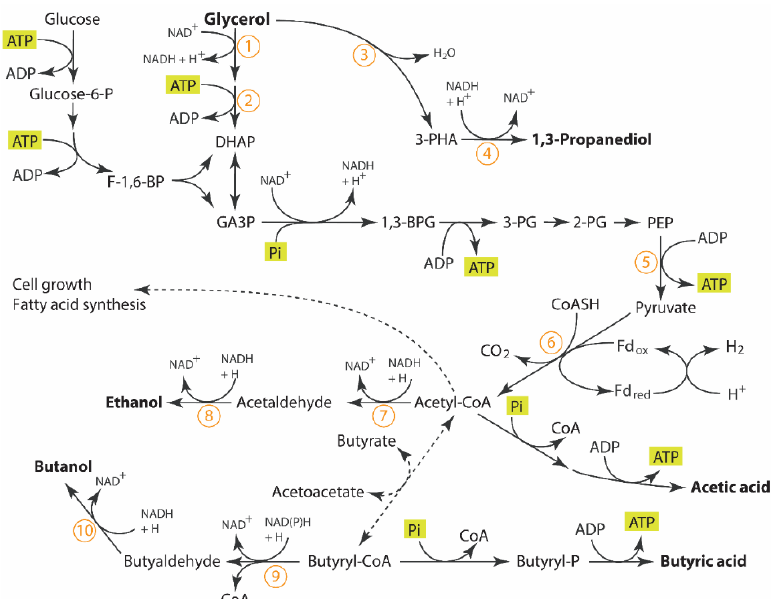
Figure 1. The possible metabolic route involved in glycerol metabolism in C. pasteurianum based on [4,5]. Key enzymes involving glycerol to butanol: 1, glycerol dehydrogenase; 2, dihydroxyacetone kinase; 3, glycerol dehydratase; 4, 1,3-propanediol dehydrogenase; 5, pyruvate kinase; 6, pyruvate-ferredoxin oxidoreductase; 7, acetaldehyde dehydrogenase; 8, ethanol dehydrogenase; 9, butyraldehyde dehydrogenase; 10, butanol dehydrogenase. Abbreviation for chemical: DHAP, Dihydroxyacetone phosphate; 3-HPA, 3-Hydroxypropionaldehyde; GA3P, Glyceraldehyde 3-phosphate; 1,3 BPG, 1,3-bisphosphoglycerate, 3PG 3-phosphoglycerate; 2PG, 2-phosphoglycerate; PEP, Phosphoenolpyruvate.